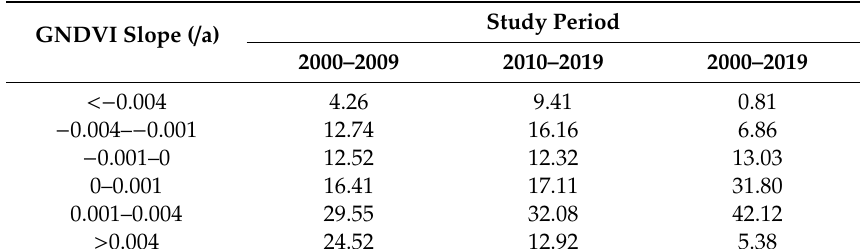
Figure 3. Interannual variation of the GNDVI on the QTP during 2000–2019. Table 2. The areal proportion of di ff erent the GNDVI slope levels in di ff erent study periods on the QTP during 2000–2019 (%).